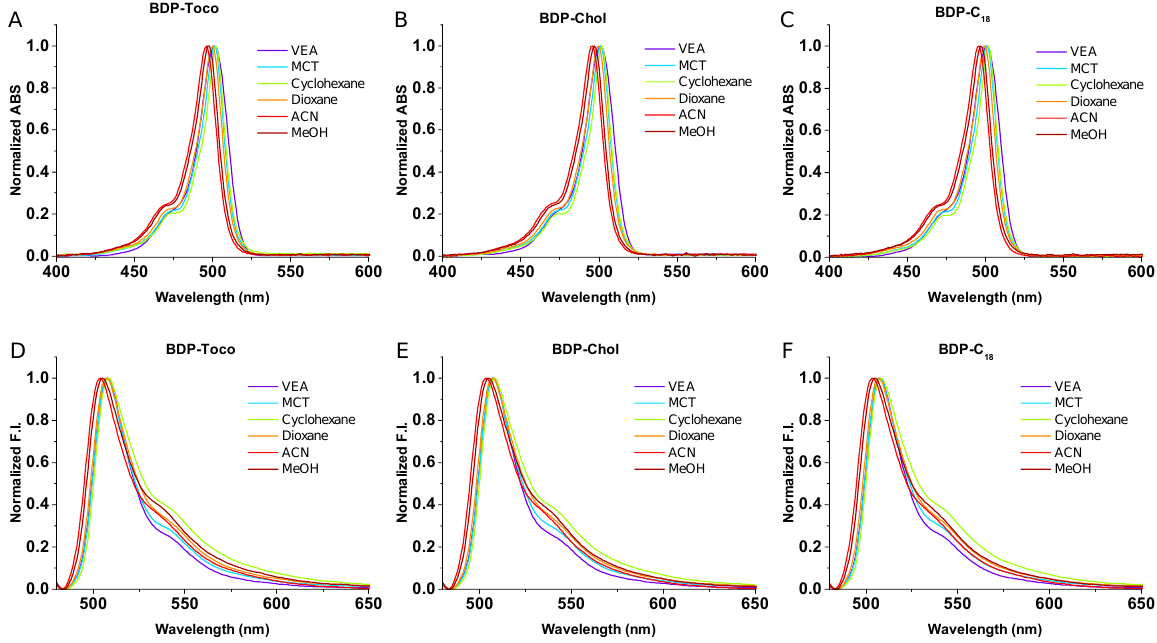
Figure 2. Normalized absorption ( top ) and emission ( bottom ) spectra of BDP-Toco ( A , D ), BDP-Chol ( B , E ) and BDP-C 18 ( C , F ) in various solvents and oils at 1 μM. Excitation wavelength was 470 nm.